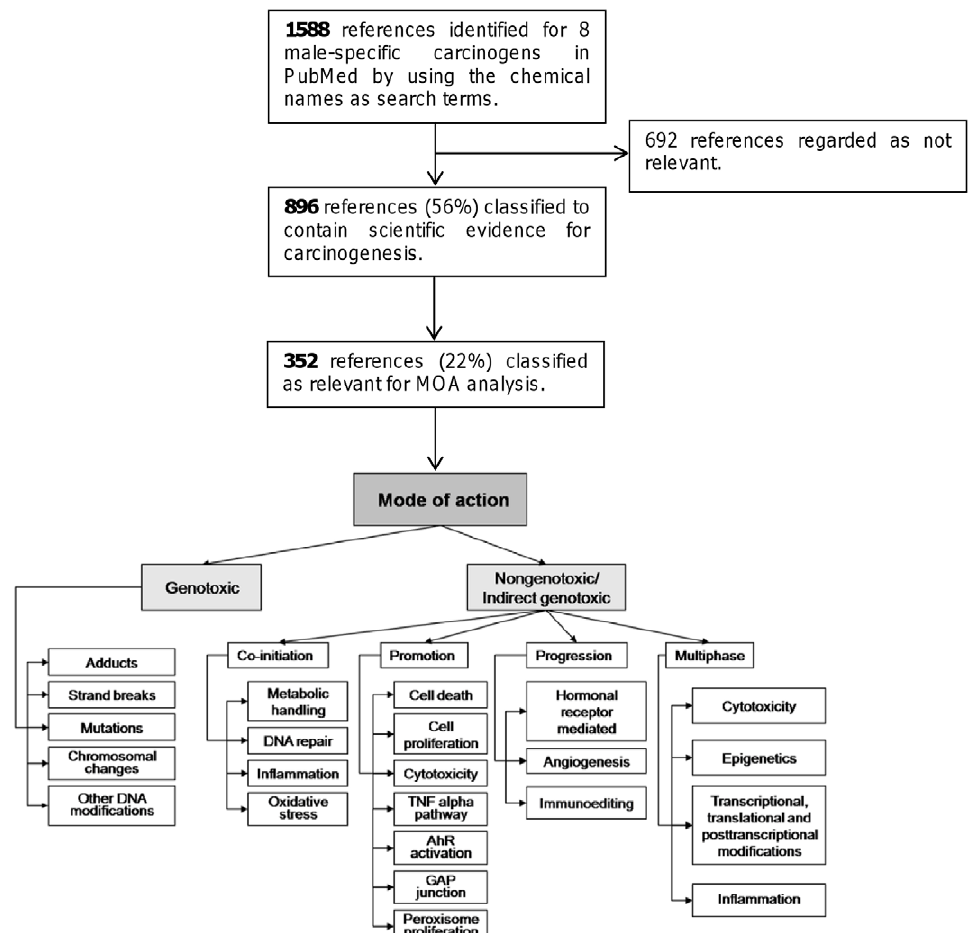
Figure 1. Flow chart of the tool used for classifying the abstracts.